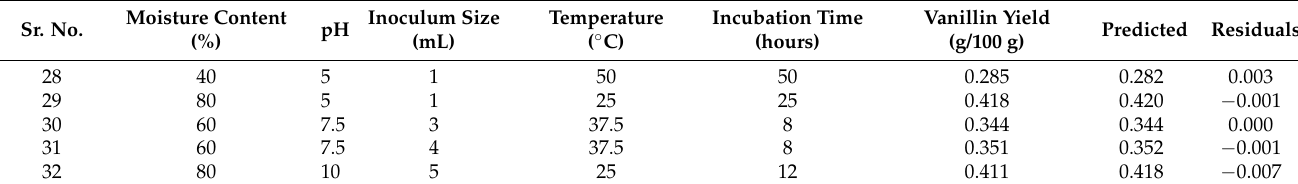
Table 4. ANOVA study on CCD response parameters.